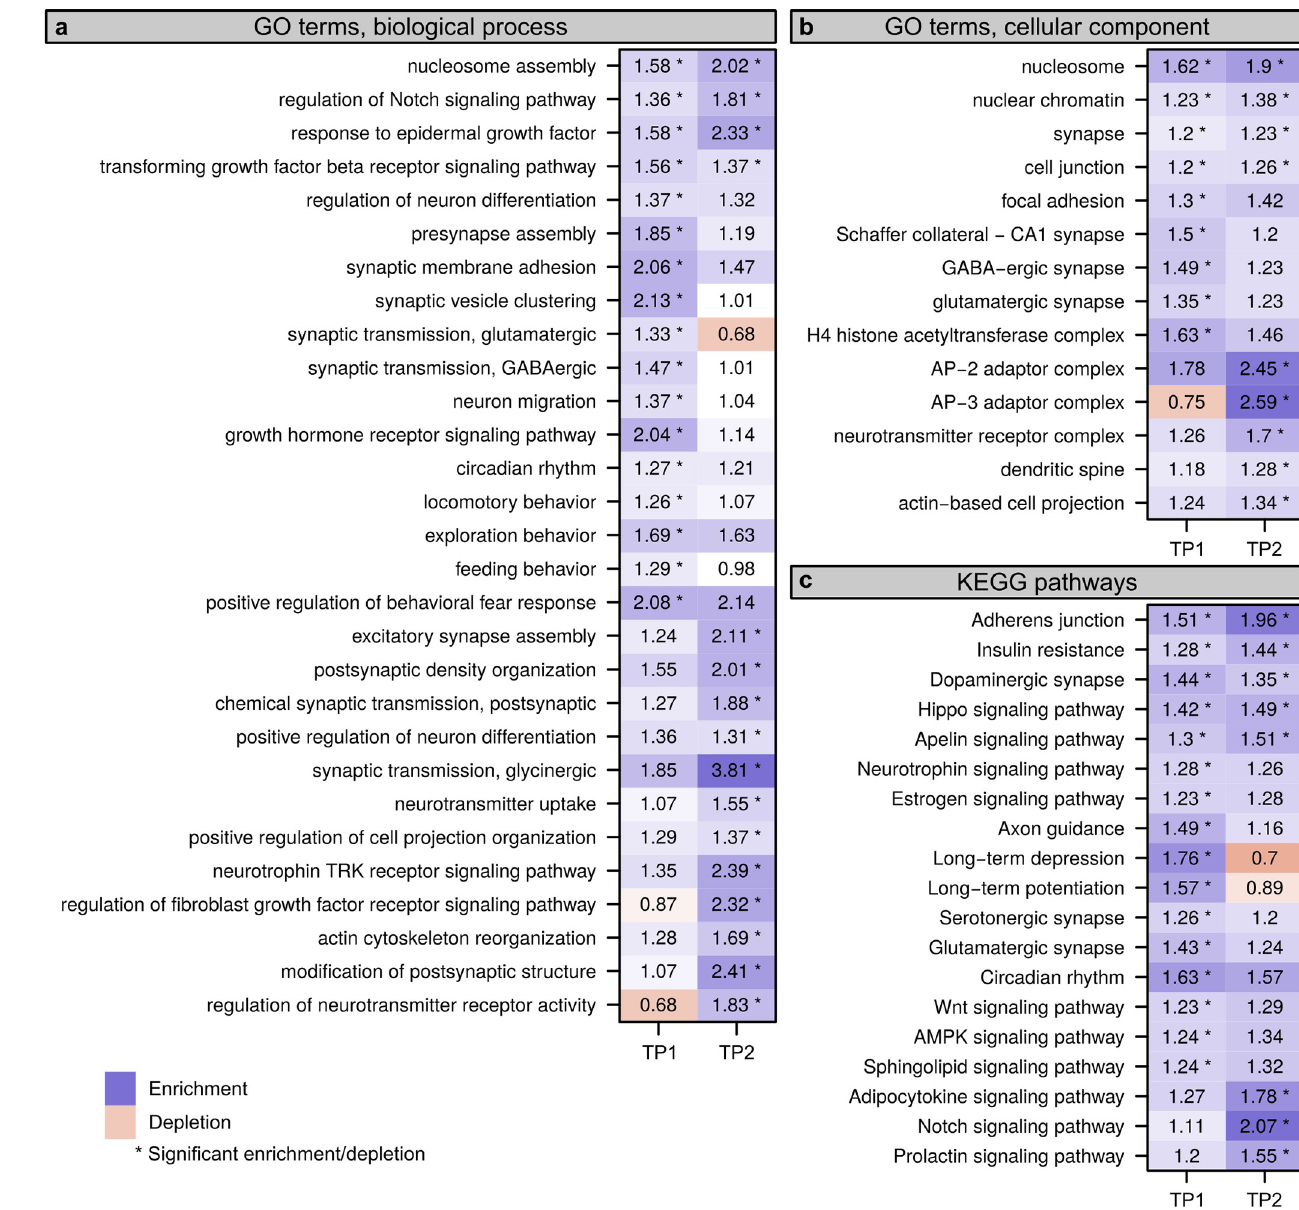
Fig 4. Predicted biological processes, cellular components, and KEGG pathways affected by differential rearing environment. GO analysis of genes showing differential chromatin accessibility between the different RF presented for each TP ( a-b ); KEGG pathway analysis of the genes showing differential chromatin accessibility between the different RFs for each TP. Fields marked with an asterisk depict comparisons that were statistically significant between TPs (two-sided Fisher’s exact test, adjusted for multiple testing, FDR < 0.05). FDR, false discovery rate; GO, Gene Ontology; KEGG, Kyoto Encyclopedia of Genes and Genomes; RF, rearing facility; TP, time